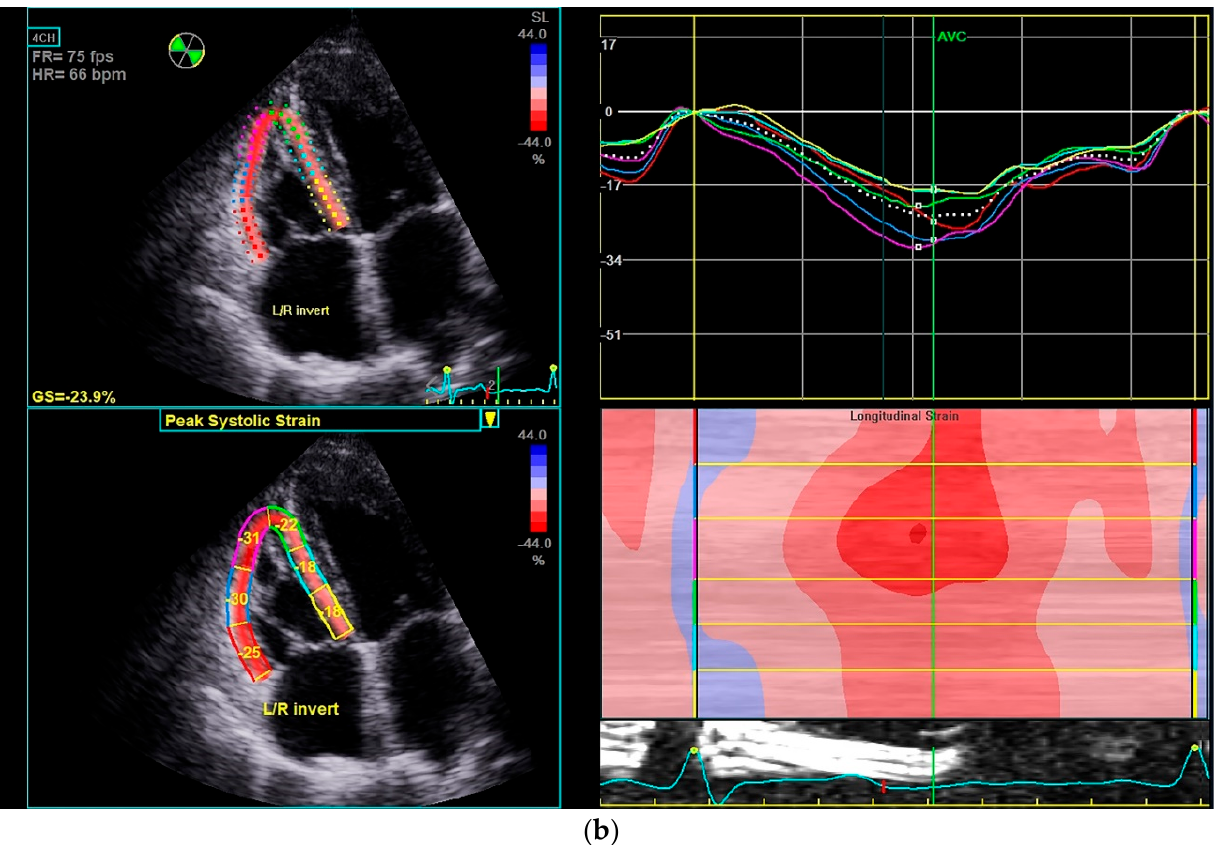
Figure 2. Example of the RV strain measurements in a patient of Group A ( a ) at the baseline (RV4CSL = − 18.8%) and ( b ) after the 1-year exercise training program (RV4CSL = − 23.9%).